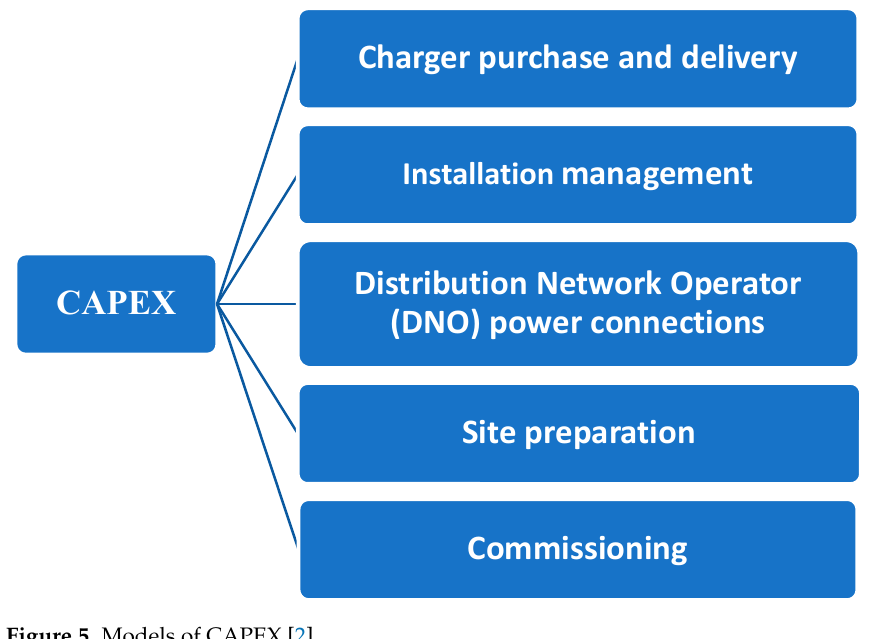
Figure 5. Models of CAPEX [2]. Table 6. Summary of CAPEX parameters [2].